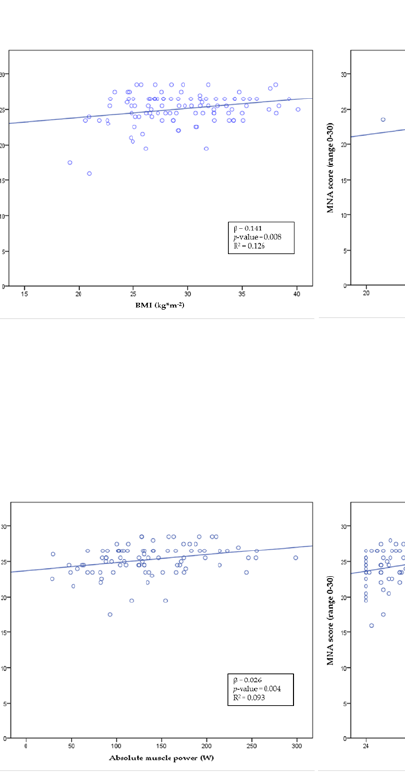
Figure 3. The relationship between the MNA score and functional status, physical performance, and physical activity, controlling for age and sex. BMI: body mass index; SPPB: Short Physical Performance Battery; APAFOP: Assessment of Physical Activity in Frail Older People. β : standardized regression coefficient; R 2 : coefficient of determination.